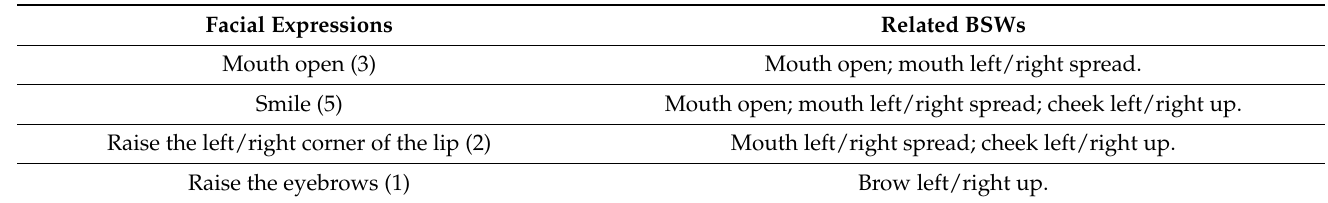
Table 2. Facial expressions and related BSWs. Numbers in the parenthesis represent the number of BSWs related to each facial